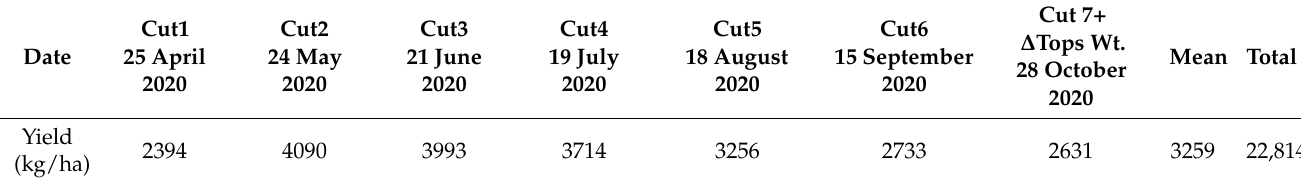
yield (2305 (kg/ha)) on 19 October 2020 for the fair comparison as shown in Table 11. Table 11. Forage yield simulated for the first six cuttings and estimated for